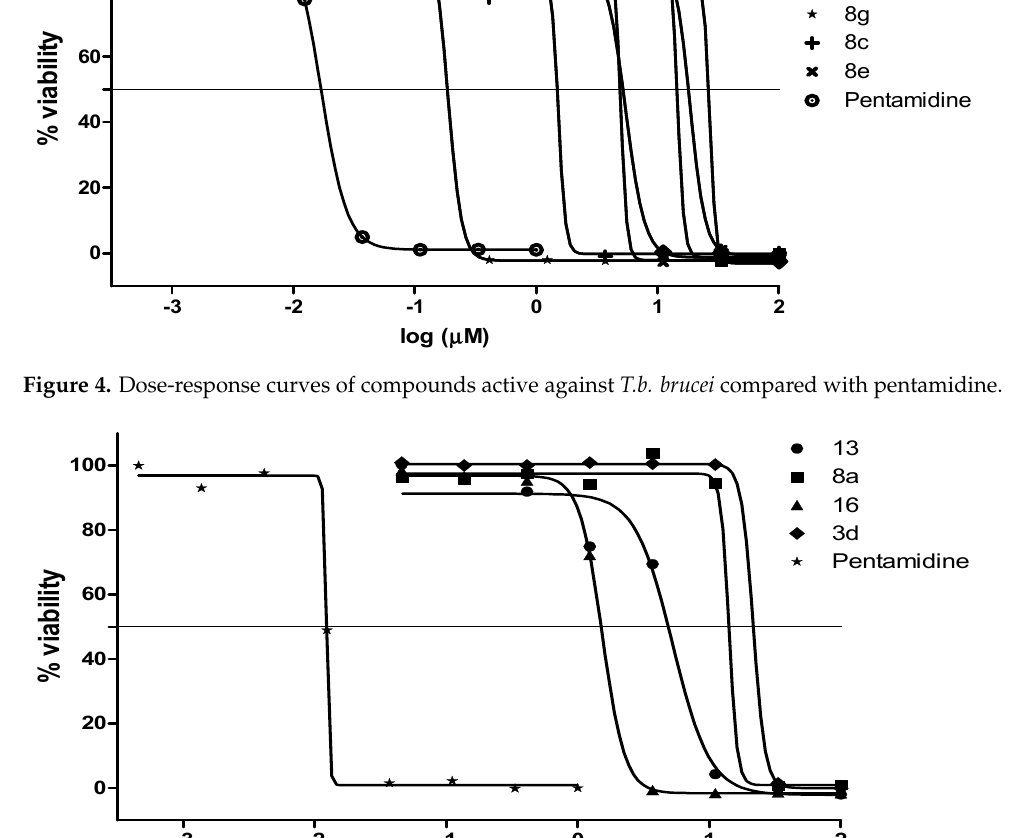
Figure 5. Dose-response curves of compounds active against T.b. brucei compared with pentami- dine.